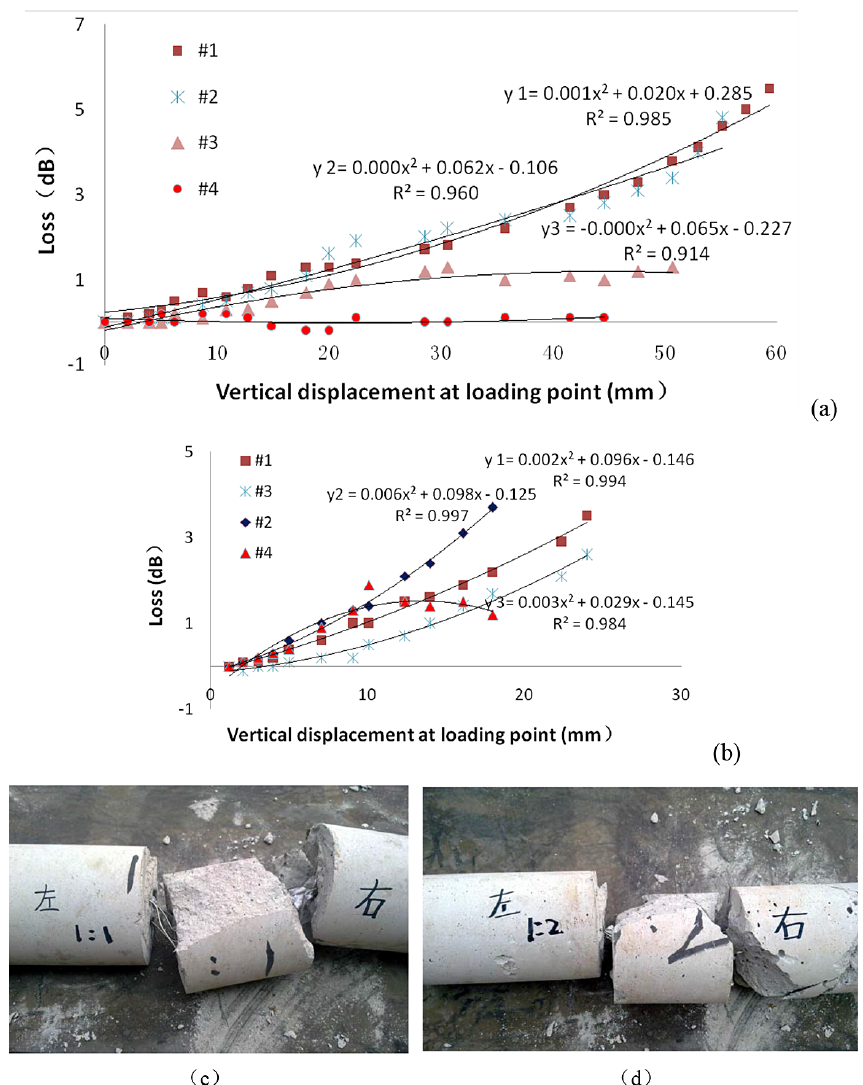
Figure 2. Results of double shearing tests. Relationship between fiber optical loss and vertical displacement at loading point. (a) Model 1, (b) model 2. Photos of model test completed. (c) Model 1, (d) model